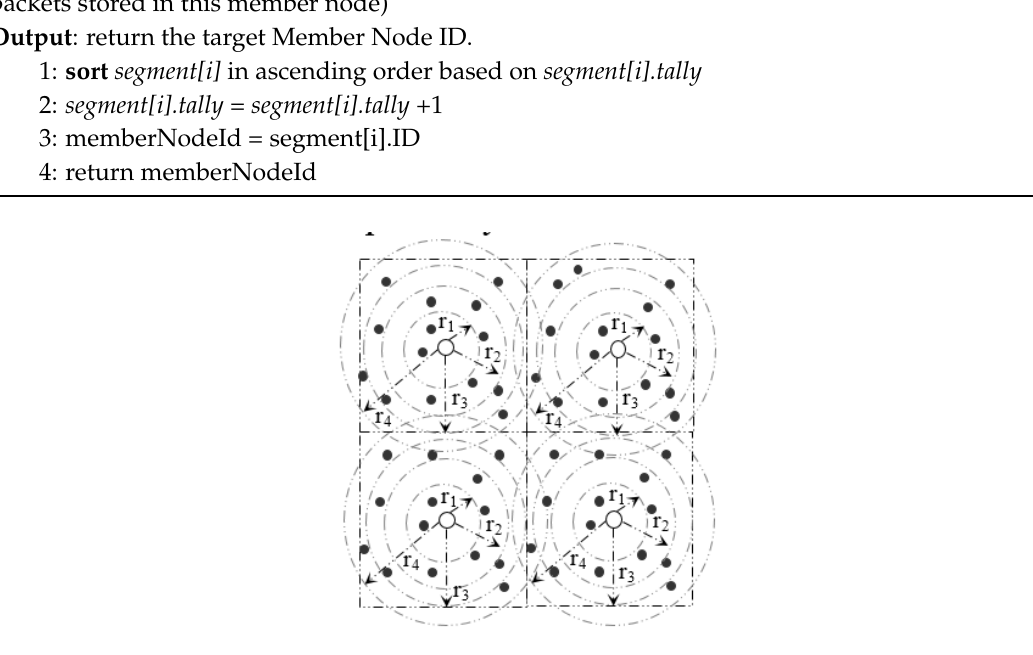
Figure 6. Formation of Segments inside a Sector.